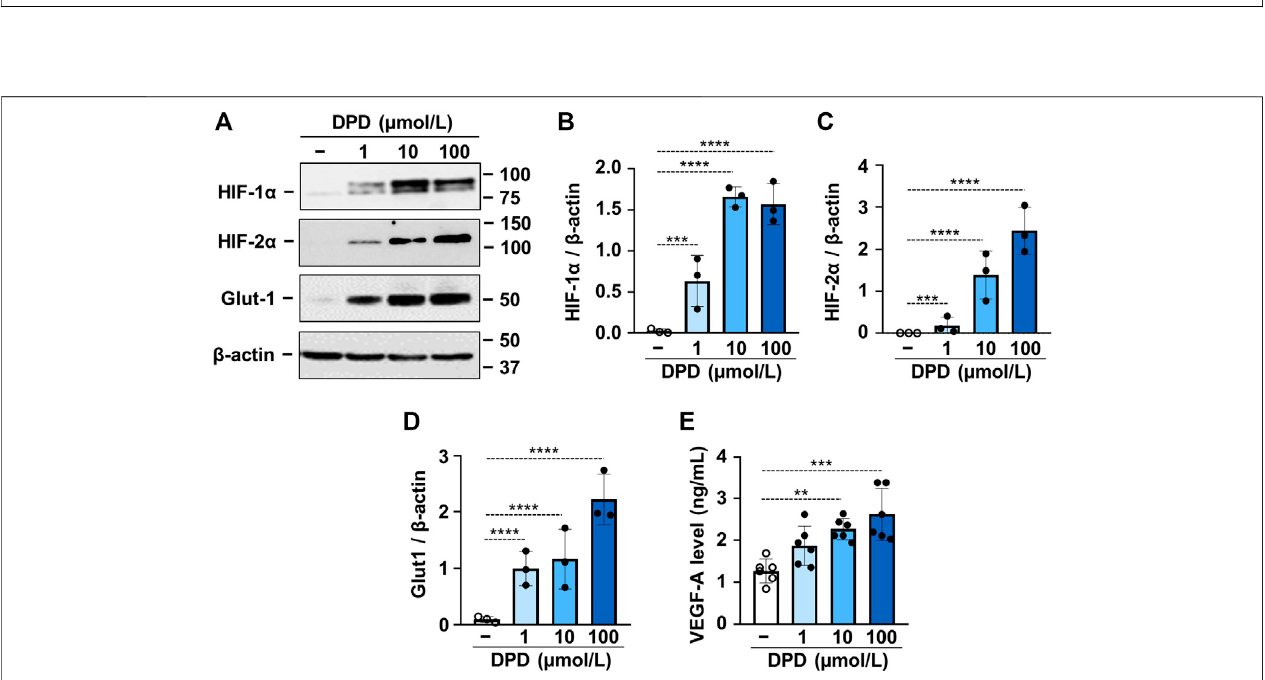
FIGURE2| DPDtriggershypoxiaresponseinVSMCs.VSMCs wereculturedintheabsenceorpresenceofDPD(1 – 100 μ mol/L). (A – D) Proteinexpression ofHIF- 1 α ,HIF-2 α ,andGlut-1inwholecelllysateswasevaluatedafter24 h.Membraneswerereprobedfor β -actin. (A) RepresentativeWesternblotsanddensitometryanalyses on the relative expression of (B) HIF-1 α , (C) HIF-2 α , and (D) Glut-1 normalized to β -actin are depicted ( n = 3). (E) VEGF-A levels (24 h) were determined from cellular supernatantbyELISA( n =6).Dataareexpressedasmean±SD. (A – D) Ordinaryone-wayANOVAfollowedbyDunnett ’ smultiplecomparisonstestand (E) ordinary one-way ANOVA followed by Tukey ’ s multiple comparisons test were used to obtain p values. ** p < 0.01, *** p < 0.005, **** p < 0.001.